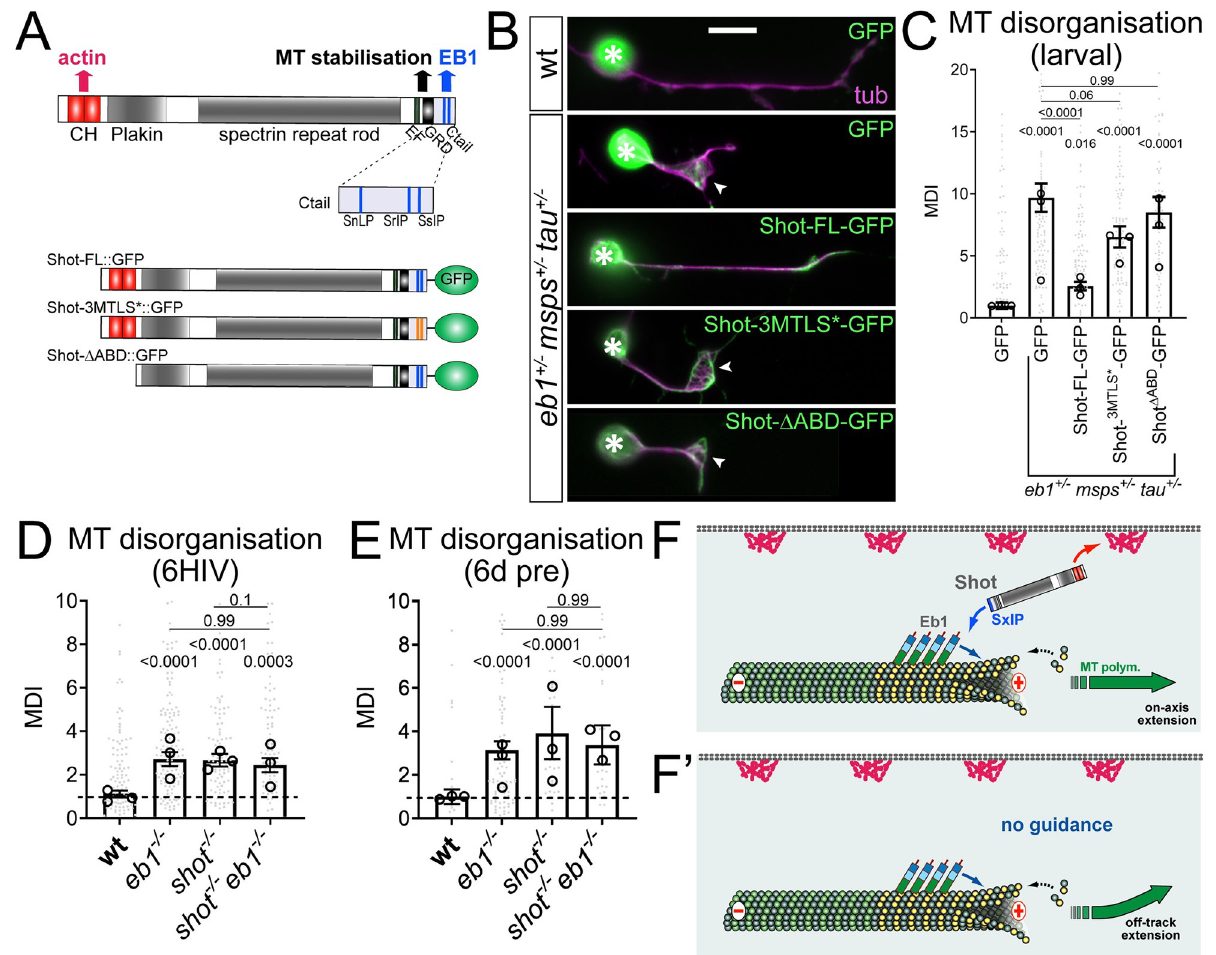
Fig 6. Shot-mediated guidance mechanistically links Eb1 at MT plus-ends to bundle organisation. A ) Schematic representation of Shot constructs (CH, actin-binding calponin-homology domains; EF, EF-hand motifs; GRD, MT-binding Gas2-related domain; Ctail, unstructured MT-binding domain containing Eb1-binding SxIP motifs in blue); in Shot-3MtLS � ::GFP the SxIP motifs are mutated (orange lines). B ) Fixed primary neurons at 18HIV obtained from late larval CNSs stained for GFP (green) and tubulin (magenta), which are either wild-type (top) or Eb1 04524/+ msps A/+ tau KO/+ triple-heterozygous (indicated on right) and express GFP or either of the constructs shown in D; scale bar 10 μ m. C ) Quantification of MT curling of neurons as shown in B. D,E ) MT curling in shot 3/3 Eb1 04524/04524 double-mutant neurons is not enhanced over single mutant conditions assessed in fixed embryonic primary neurons at 6HIV (D) or 12HIV following 6 day pre-culture (E). In all graphs data were normalised to parallel controls (dashed horizontal lines) and are shown as mean ± SEM from at least two independent repeats with 3 experimental replicates each; large open circles in graphs indicate median/mean of independent biological repeats. P-values obtained with Kruskall-Wallis ANOVA tests are shown above bars. F,F’ ) Model derived from previous work [22], proposing that the spectraplakin Shot cross-links Eb1 at MT plus-ends with cortical F-actin, thus guiding MT extension in parallel to the axonal surface; yellow dots represent GTP-tubulins providing high affinity sites for Eb1-binding. For raw data see S6 Data.